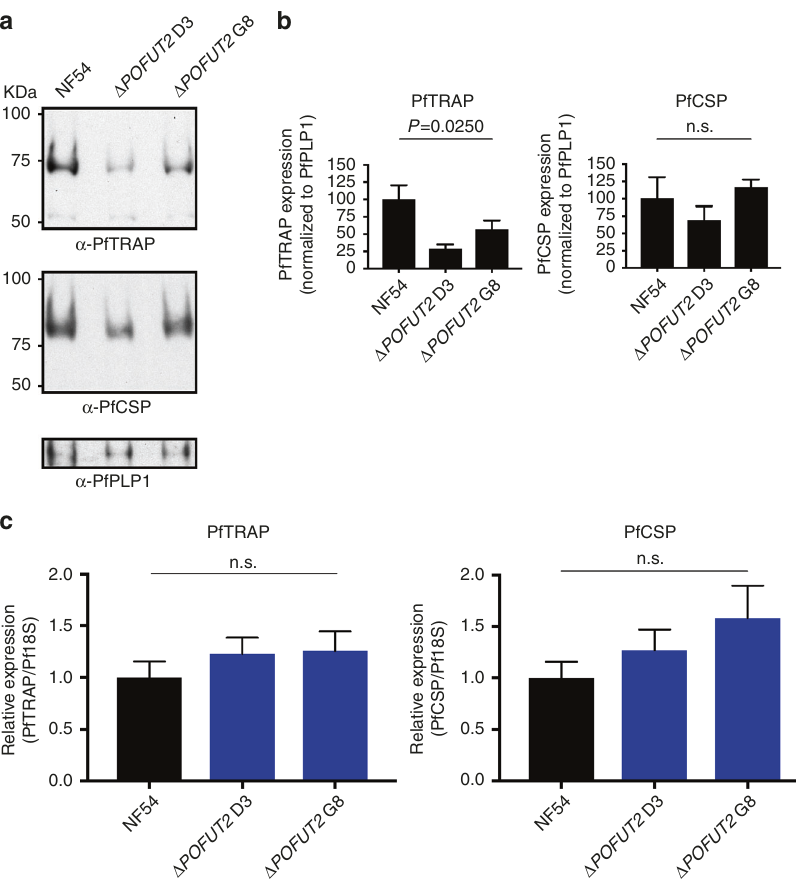
Fig. 5 POFUT2 stabilizes TSR proteins in P. falciparum . a Western blot analysis of 30,000 salivary gland sporozoites per lane using antibodies to PfTRAP and PfCSP. Anti-PfPLP1 was used as a loading control. The same blot was probed consecutively with each antibody. b Densitometry of PfTRAP and PfCSP levels in sporozoites measured by immunoblotting and standardized to the PfPLP1 loading control. Data are mean ± S.E.M. and pooled from three independent immunoblots. c Abundance of PfTRAP and PfCSP mRNA transcripts in salivary gland sporozoites relative to Pf18S , measured by qRT-PCR. No differences were observed for either Δ POFUT2 clone compared to NF54 for PfTRAP ( P = 0.5003) and PfCSP ( P = 0.3104) mRNA. Data is the mean ± S.E.M. of four independent experiments. P -values are for both mutant clones compared to NF54, calculated using the Kruskal –